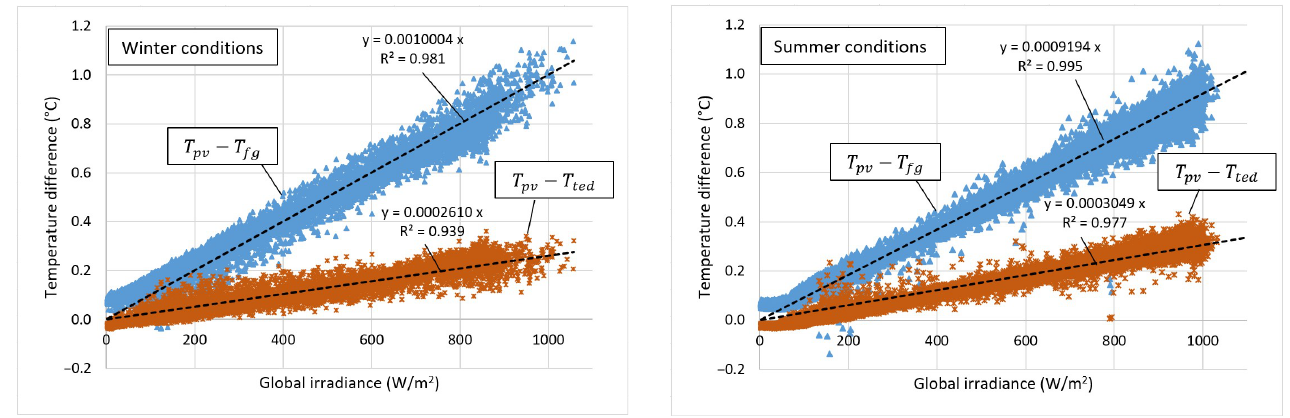
Figure 12. Temperature difference between PV layer and front glass/tedlar surfaces. Winter and summer conditions.